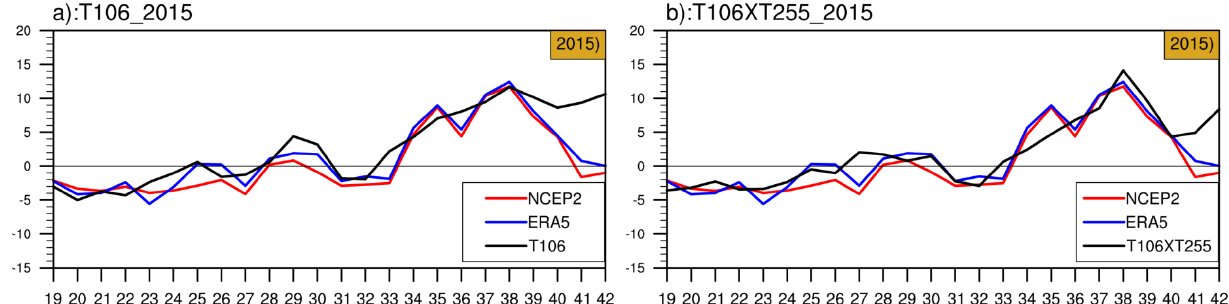
Figure 7. Pentad-by-pentad evolution of zonal wind averages (y − axis; unit: m.s −1 ) in the SCSSM monitoring area (5° − 15° N, 110° − 120° E) for 2015 (for lead times of 1 − 31 days) from 19th pentad to 42nd pentad (x − axis). Red and blue lines indicate the result of NCEP2 and ERA5, respectively, with the black lines representing the two schemes of T106 ( a ) and T106 × T255 ( b ). From the 21st to the 36th pentad, with reference to the 5°–15° N region, T106 predicts